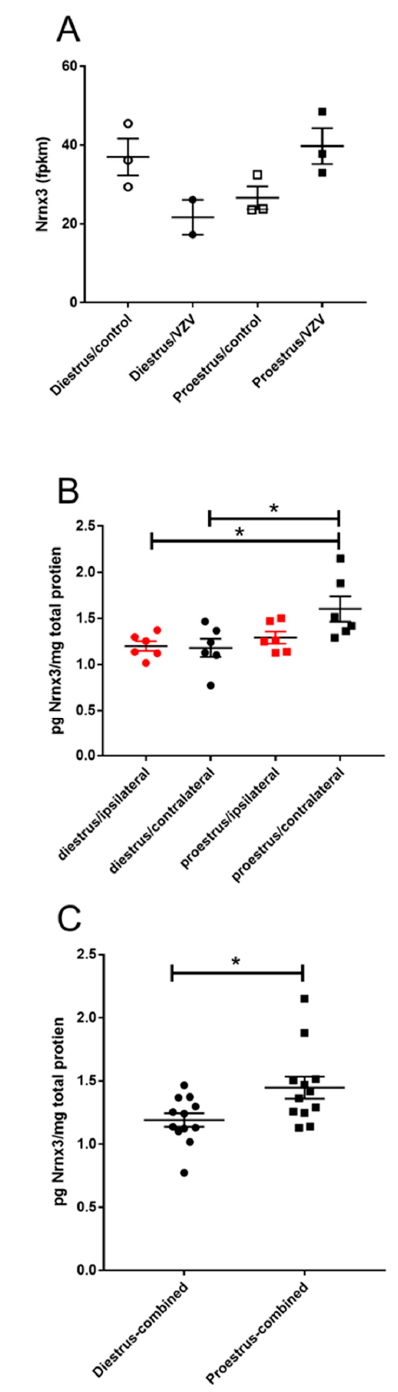
Figure 2. Expression of neurexin 3 (Nrxn3) significantly increased in the parabrachial region during proestrus. Rats were injected with varicella zoster virus in the left whisker pad to induce orofacial pain. Parabrachial brain tissue was collected from these female rats during the proestrus and diestrus phase of the estrous cycle. This tissue was analyzed for RNA (panel A ) and protein (panels B , C ). In panel ( A ) control animals received an injection of 0.9% saline in the left whisker pad. In panel ( B ) the right (contralateral to VZV injection) and left (ipsilateral to VZV injection) side of the brain was analyzed separately and in panel ( C ) the protein content from both sides of the brain were combined. Fragments Per Kilobase of transcript per Million mapped reads (fpkm). The asterisk indicates a significant di ff erence between groups p <